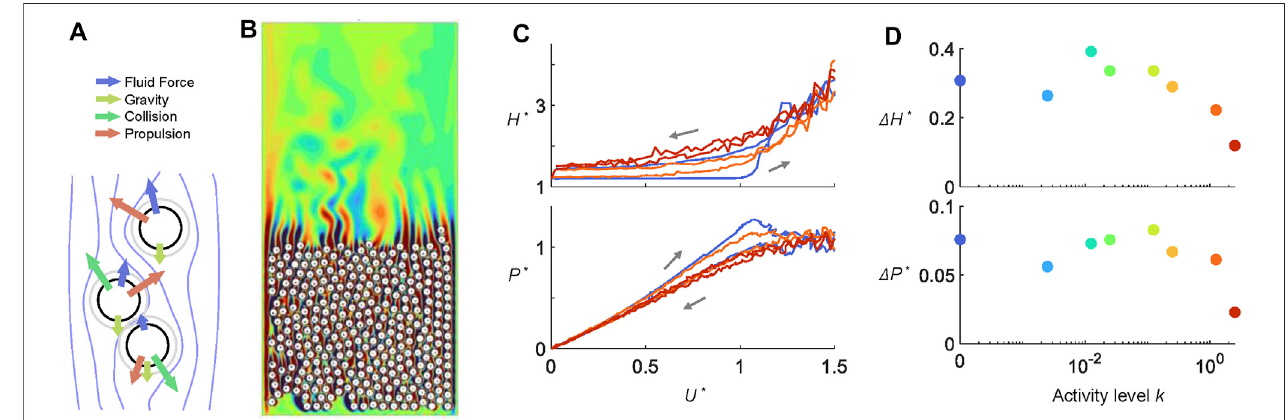
FIGURE 4 | Larva fl uidization-de fl uidization simulations. (A) Agents move under fl uid forces, collisional forces, and a random force that mimics larval activity. (B) A snapshot from the simulation of 396 active cylinders in ramping air fl ows. Contour colors represent the magnitude of the vorticity fi eld. (C) Hysteresis diagram and (D) hysteresis metric Δ H * and Δ P * of cylinders at various activity level k . In both (C – D) , k (cid:1) 2.5 is shown in red, k (cid:1) 1.25 in orange, and k (cid:1) 0 in blue.